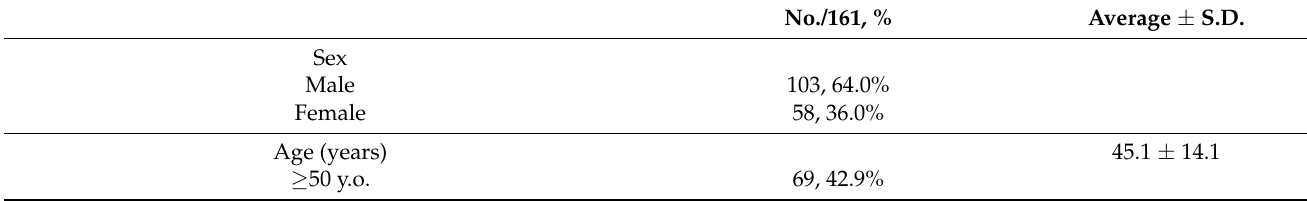
Table 1. General characteristics of the 161 first responders from the Province of Parma participating in the survey (note: SIV = Seasonal Influenza Vaccine; GP = General Practitioner; OPh = Occupational Physician; SD = Standard Deviation). In the survey, a “positive” vaccination status was defined as follows: two shots for measles, one booster shot against pertussis within the last 10 years, one shot for SIV for either the influenza season 2017 and/or 2018 (separately assessed). Regarding meningococcus, as several serotype-specific vaccines are available, any previous reported vaccination was considered